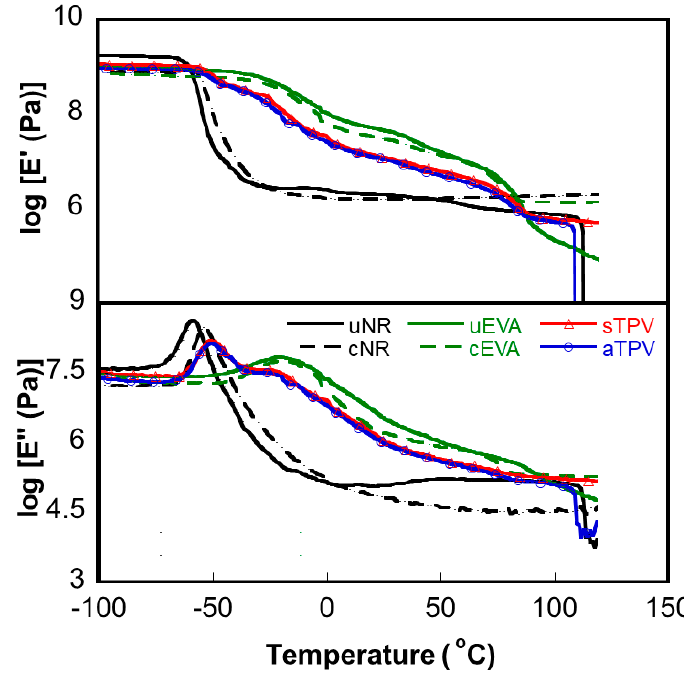
Figure 4. Tensile storage and loss moduli of uncured EVA, uncured NR, cured EVA, cured NR, and EVA/NR TPVs samples prepared with different methods.